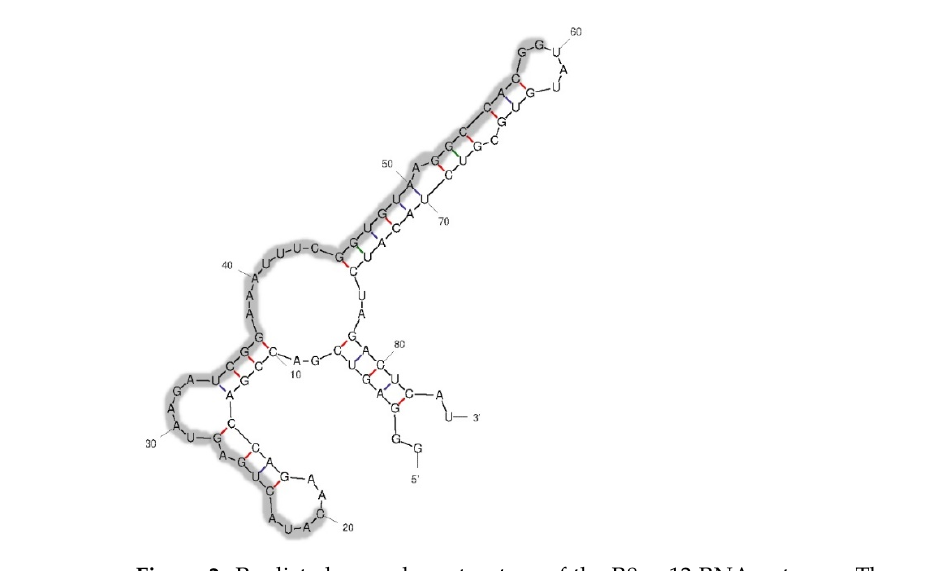
Figure 2. Predicted secondary structure of the R8-su12 RNA aptamer. The randomized region is 40-nt long and shown in the shaded area.